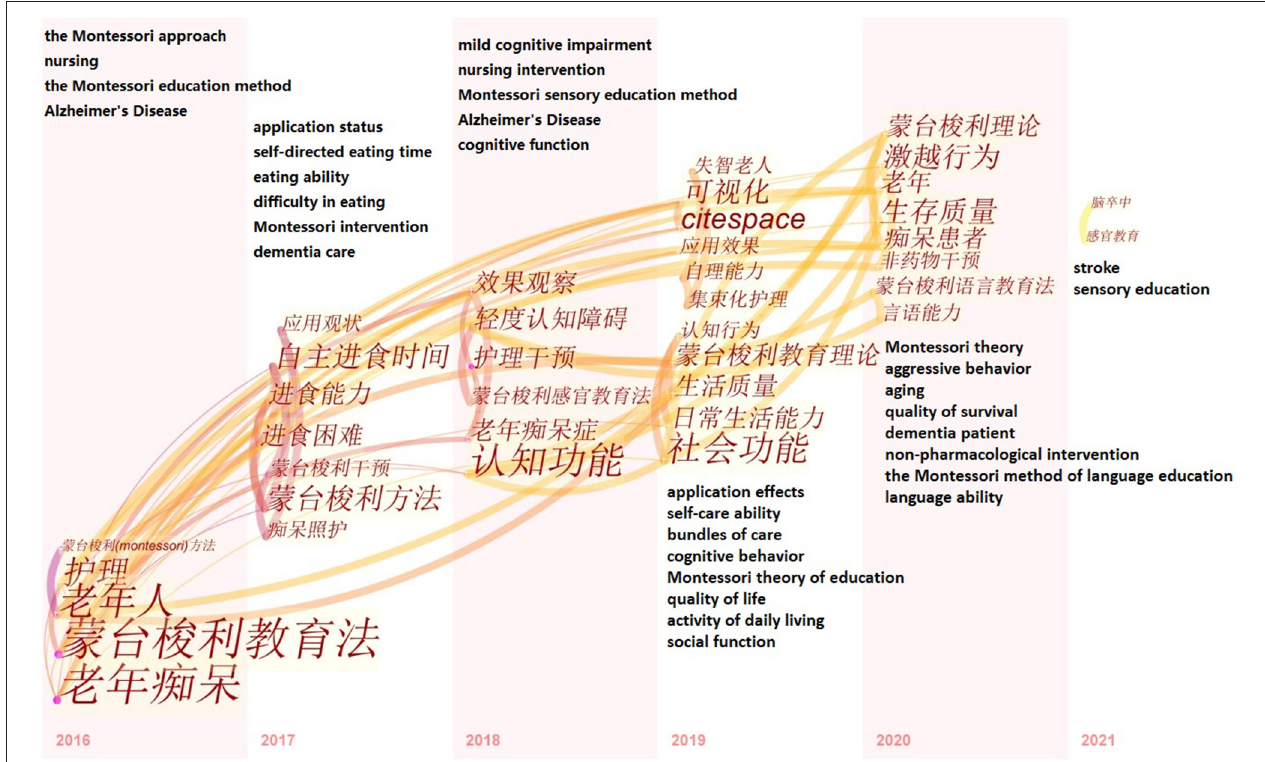
FIGURE 9 | Time zone graph of keywords in articles published in Chinese on Montessori approach to interventions for patients with dementia from 2000 to